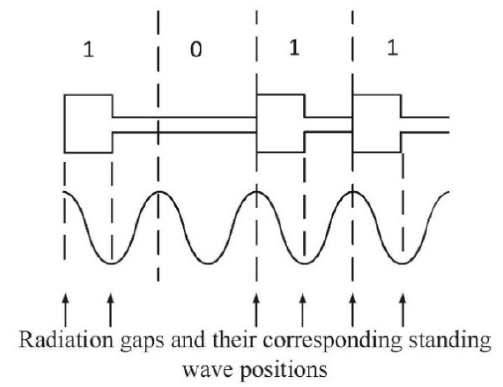
Figure 5. The topology structure corresponding to the code “1011”.